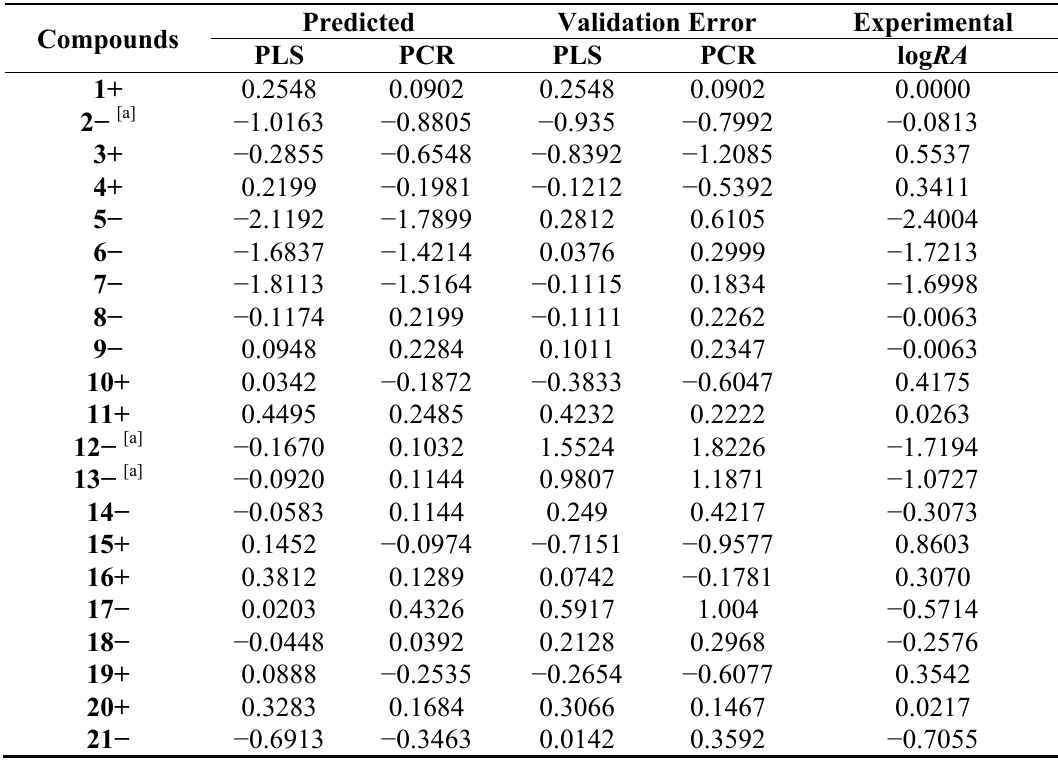
Table 5. Predicted PLS and PCR results and validation errors for log RA